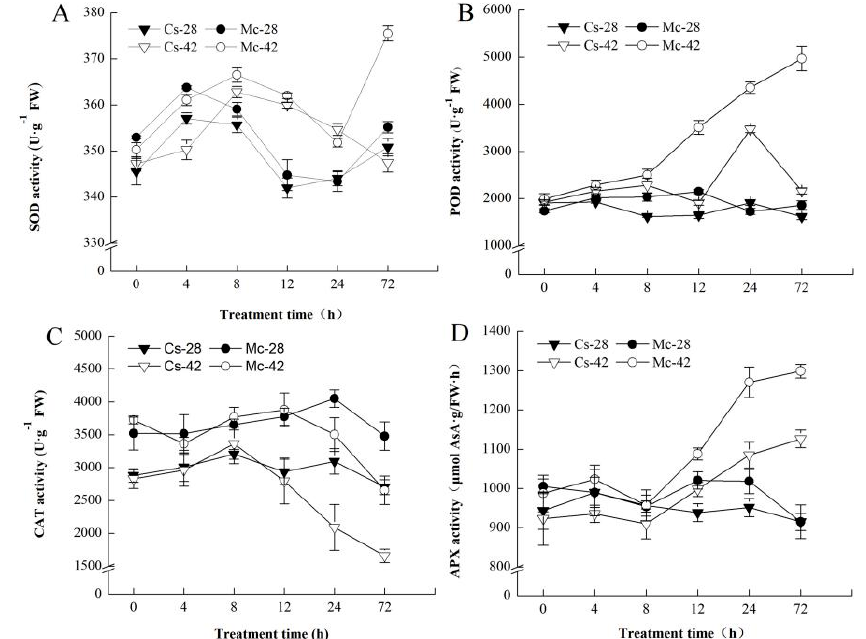
Figure 6. Interactive effects of bitter melon rootstock and grafted cucumber on the time course change of enzyme activity of ( A ) Superoxide dismutase (SOD), ( B ) Peroxidase (POD), ( C ) Catalase (CAT) and ( D ) Ascorbate peroxidase (APX) in cucumber leaves under heat stress conditions. Self-grafted plants exposed to 28 ◦ C / 18 ◦ C (day / night), Cs-28; bitter-melon-grafted plants exposed to 28 ◦ C / 18 ◦ C (day / night), Mc-28; self-grafted plants exposed to 42 ◦ C / 32 ◦ C (day / night), Cs-42; bitter-melon-grafted plants exposed to 42 ◦ C / 32 ◦ C (day / night), Mc-42. The values are the mean ± SE of three independent experiments. The bars represent the standard error.